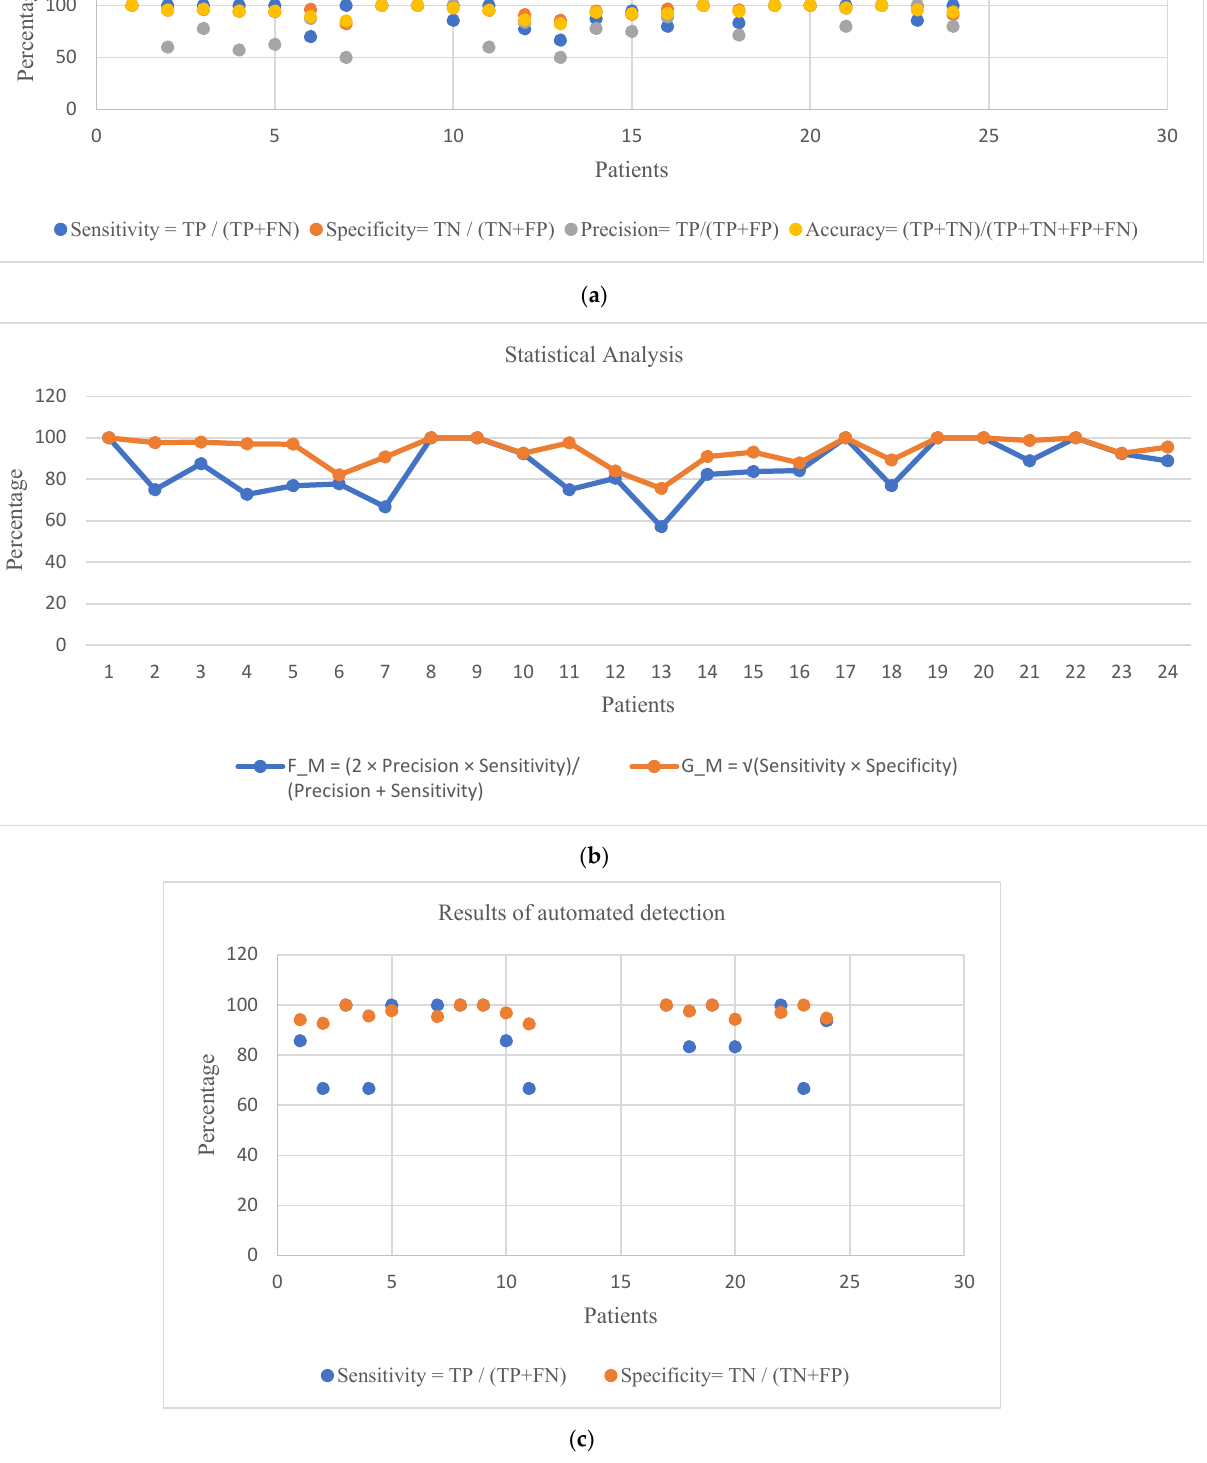
Figure 8. ( a ) Test results for the whole CHB MIT EEG dataset. ( b) Test results for the whole CHB MIT EEG dataset (F_M is F-measure; G_M is geometric mean). ( c ) Automated test results for the whole CHB MIT EEG dataset.